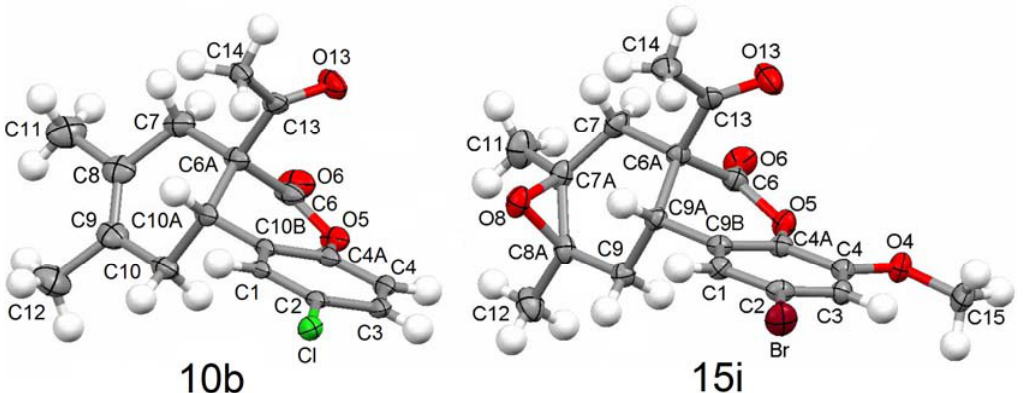
Figure 2. Molecular structure of cycloadduct 10b and 15i . Thermal ellipsoids drawn at the 50% probability